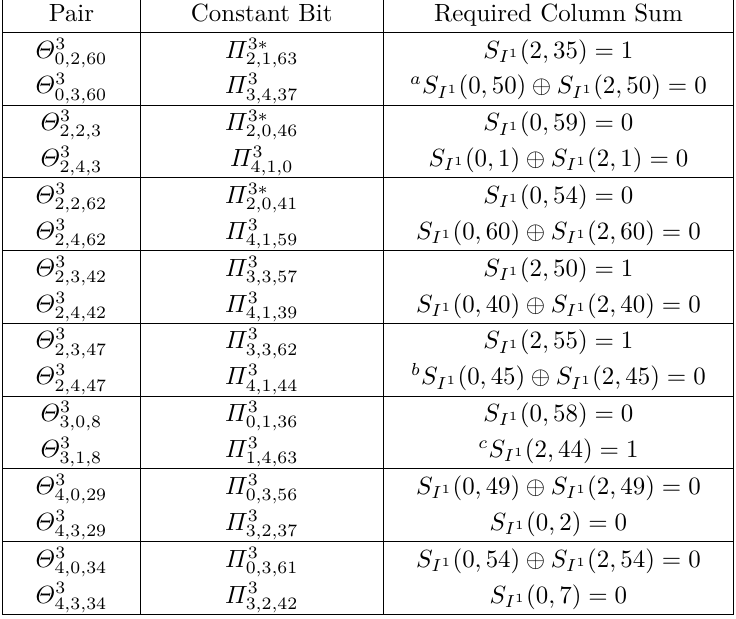
Table 5: Pairs of zero-coefficient bits (example with the starting column Π 3 Pair Constant Bit Required Column